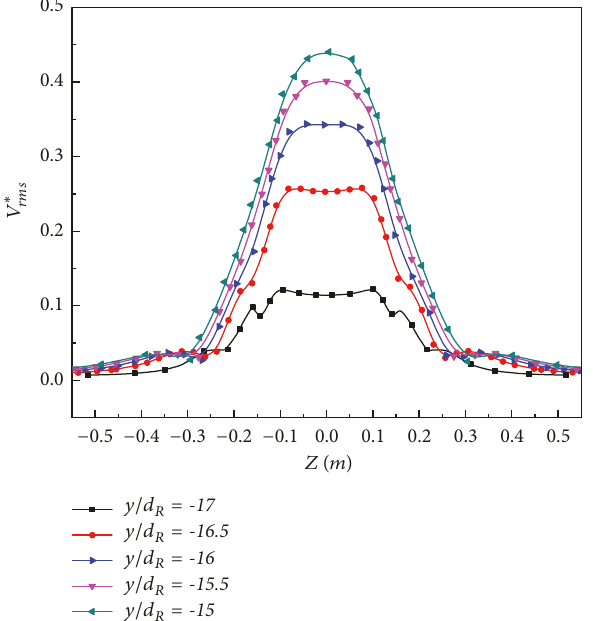
Figure 18: Dimensionless RMS temperature of different points in center